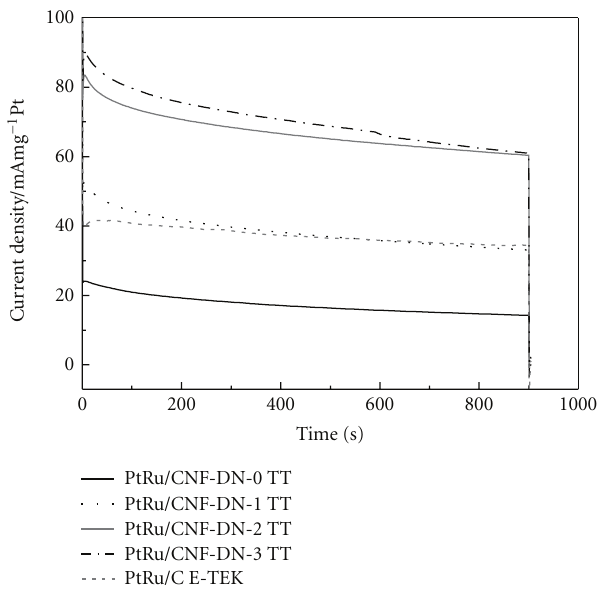
Figure 7: Current density versus time curves at room temperature for methanol oxidation on Pt-Ru synthesized catalysts. Supporing electrolyte: 0.5 M H 2 SO 4 . Methanol concentration: 2.0 M. Applied potentials: 0.55